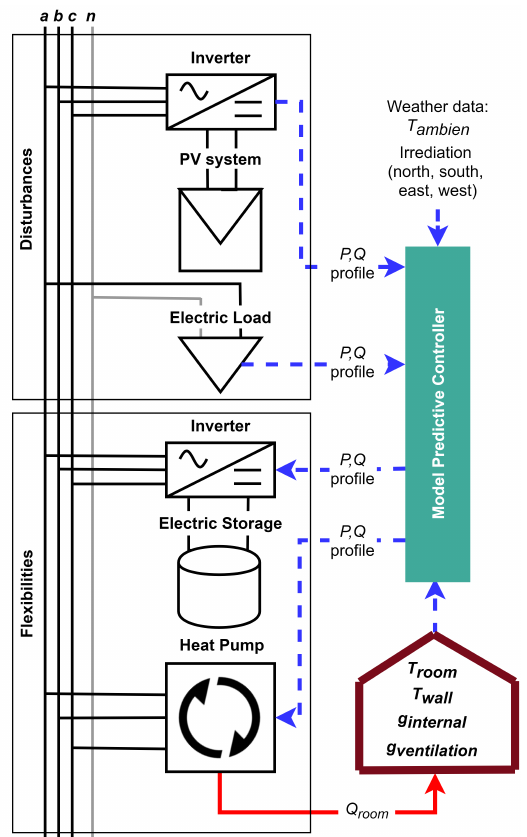
Figure 4. Schematic of three-phase HEMS with various electrical and thermal components. It can be observed that the electric appliances can have single, two or three-phase connection